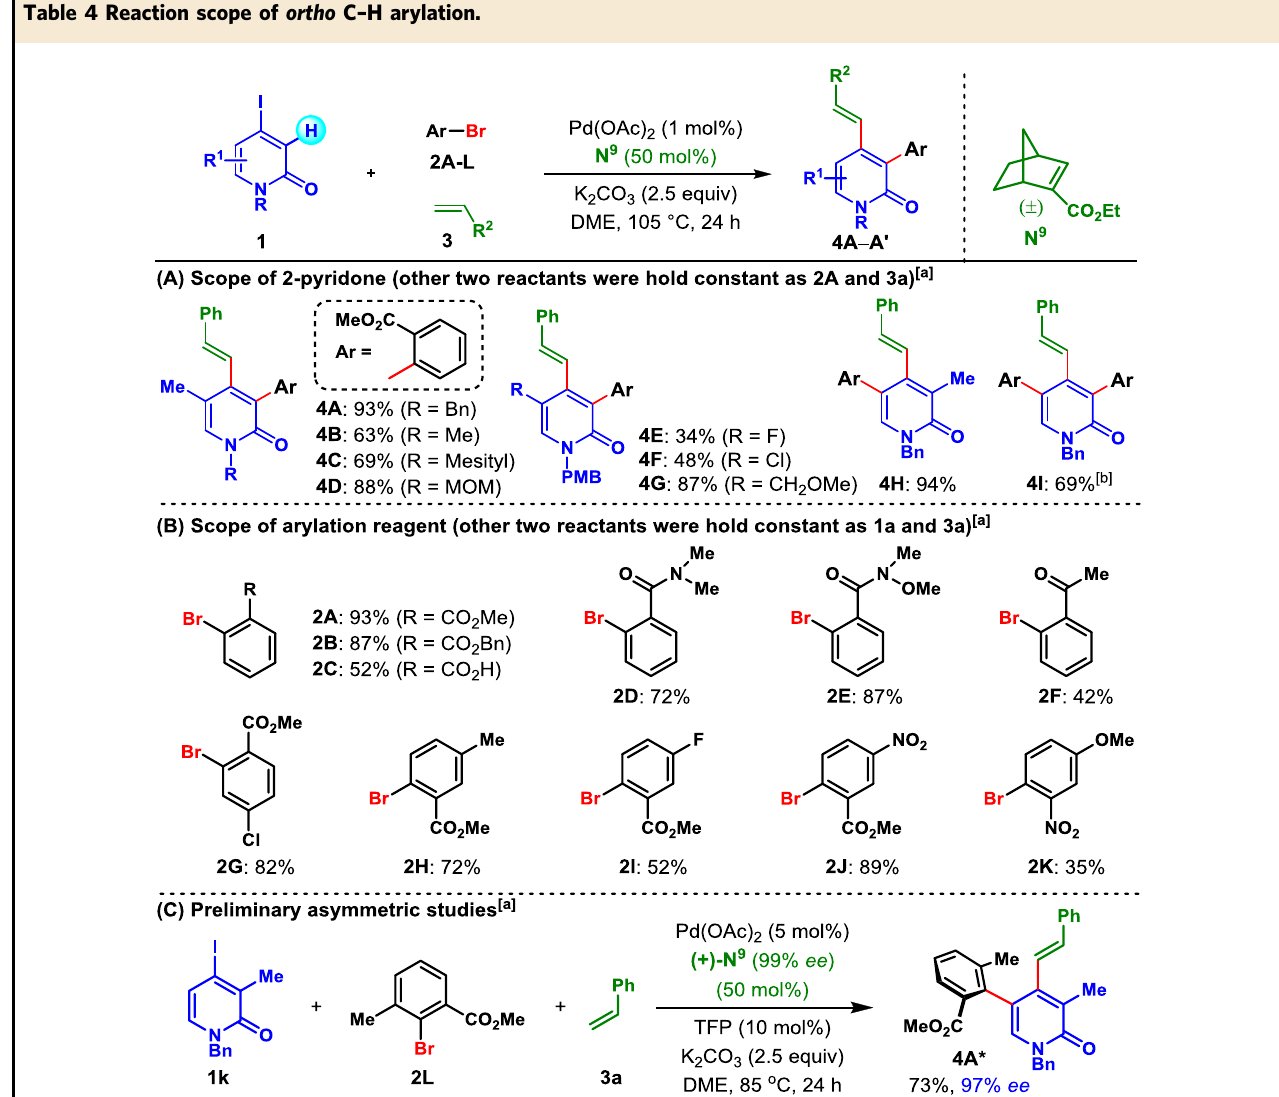
Table 4 Reaction scope of ortho C – H